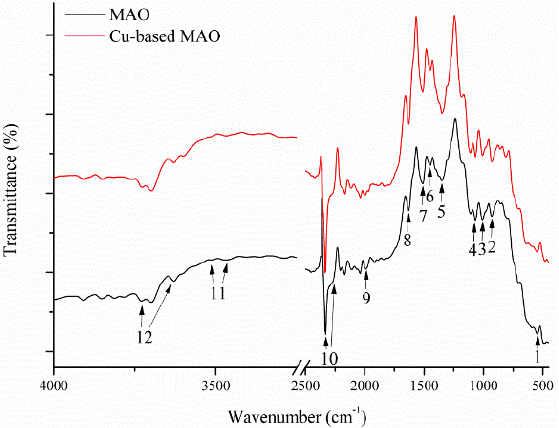
Figure 6. FTIR spectra of the coatings at post-immersion in SBF at 36.5 ◦ C for 28 days: (black line) the MAO coating and (red line) Cu-based MAO coating.